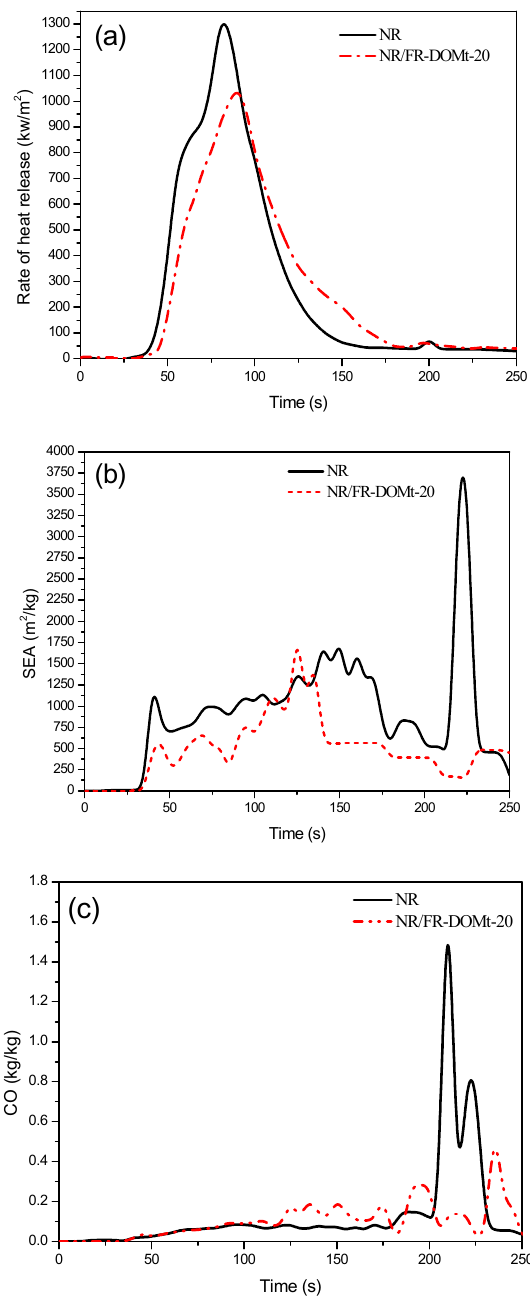
Figure 8. Cone calorimetry curves of NR and NR/FR-DOMt-20 ( a ) HRR, ( b ) SEA, ( c ) CO concentration.